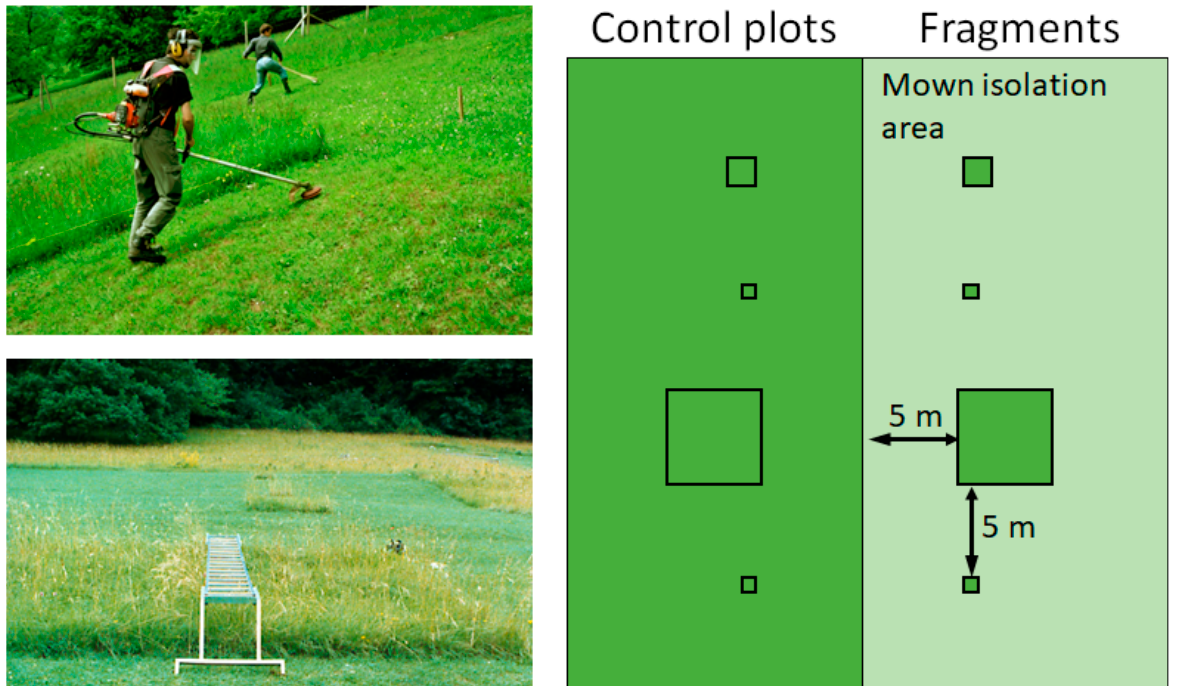
Figure 2. Experimental design. Starting in 1993, areas of three semi-natural, dry calcareous grasslands in the Jura mountains (Switzerland) were experimentally fragmented by regular mowing around the fragments. A block (29 m × 32 m) contained one large (4.5 m × 4.5 m), one small (1.5 m × 1.5 m) and two tiny (0.5 m × 0.5 m) fragments, as well as corresponding control plots in unmown vegetation. This type of fragmentation was maintained till the end of 1999. Non-invasive methods preventing trampling and harvesting of individuals were applied except in the final year. Photos: mowing the matrix: B. Baur (upper left); fragments with a mobile working platform: B. Braschler (lower left).